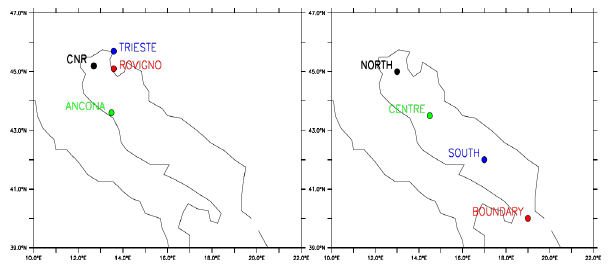
Figure 1. Adriatic Sea with the 4 points used for the sea level analysis (left panel) and for wind and MSLP analysis (right panel). N° HOURS